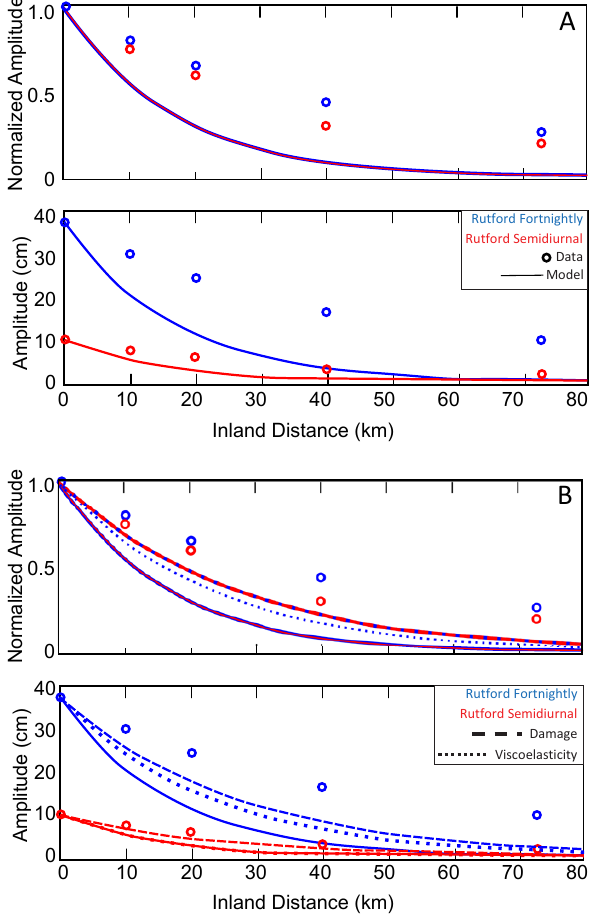
Figure 7. Comparison of observed GPS tidal displacement ampli- tudes to modeled displacement amplitudes. Circles show data taken from Rutford Ice Stream (data courtesy of H. Gudmundsson). The error on the approximated tidal displacement amplitudes is two cen- timeters (roughly the size of the symbol). Parameters for the mod- els approximating Rutford Ice Stream as are indicated in Table 5. The upper panel shows the normalized tidal amplitudes, while the lower panel shows the true amplitude values. (a) shows the dis- tance dependence of the equivalent stress calculated from linear, homogeneous elastic model results, while (b) shows the equivalent stress calculated using models accounting for elastic damage in the shear margins (dashed) and temperature-dependent viscoelasticity